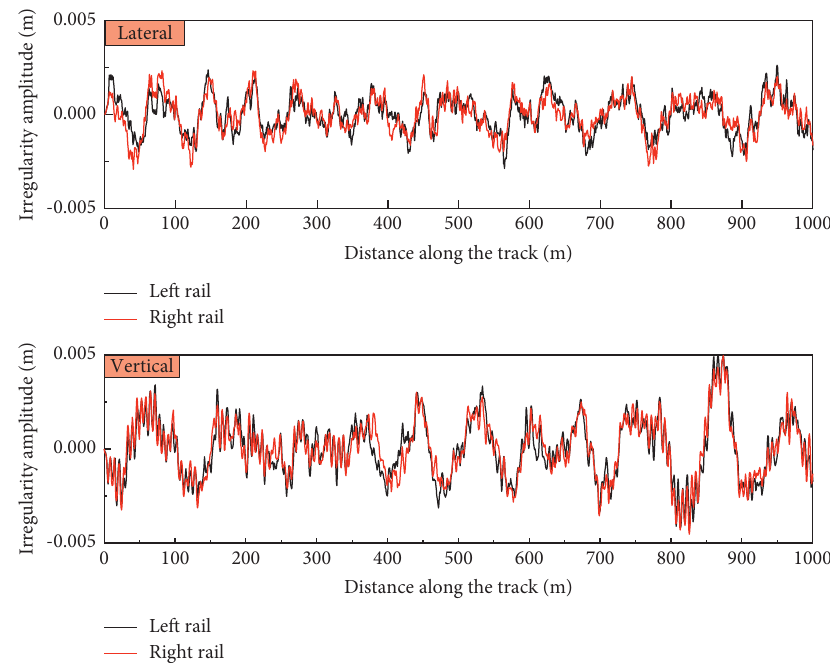
Figure 8: The random track irregularity of the Beijing-Tianjin high-speed rail line.